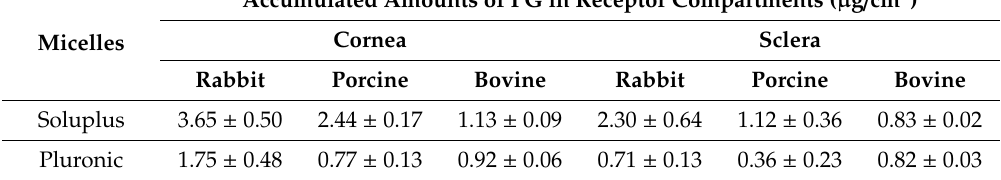
Table 4. Accumulated amounts of PG in the receptor compartments at 240 min in di ff usion tests from 20% copolymer micelle dispersion using rabbit, porcine, and bovine cornea and